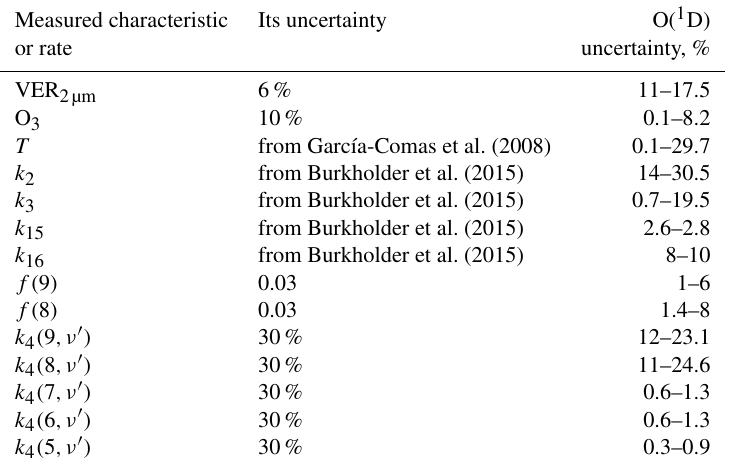
Table 2. List of systematic uncertainties of measured data and rate constants and corresponding uncertainties in derived O( 1 D) local concen-